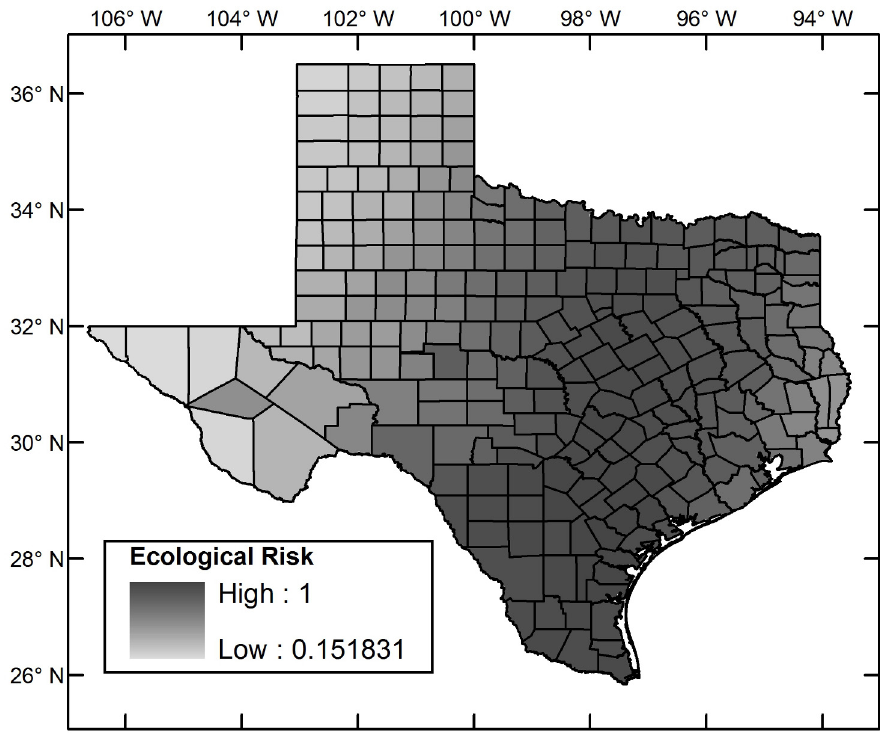
Figure 4. Ecological risk map for Chagas Disease in Texas.